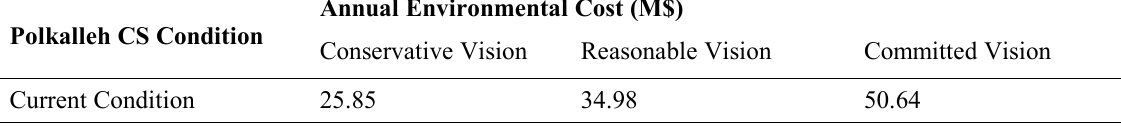
Table 11 : Annual environmental costs of CS in different environmental visions at current